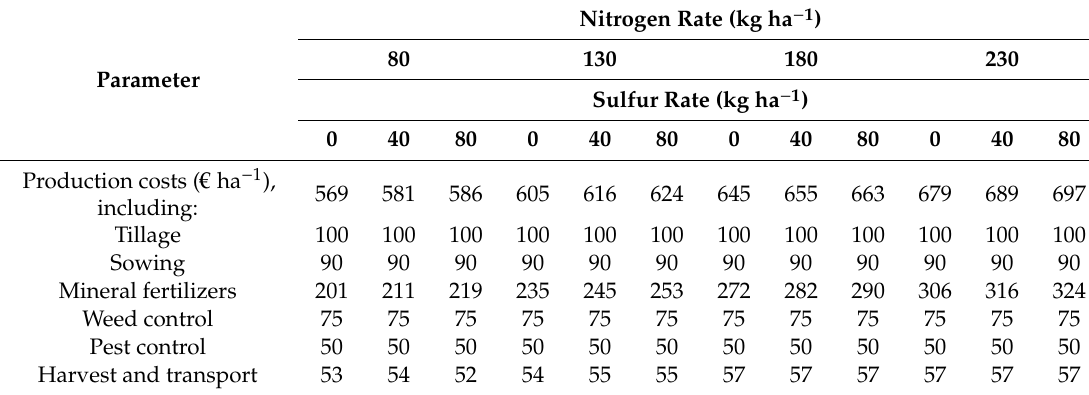
Table 8. Production costs of the long-stem hybrid cultivar of winter oilseed rape (cv. Artoga), across